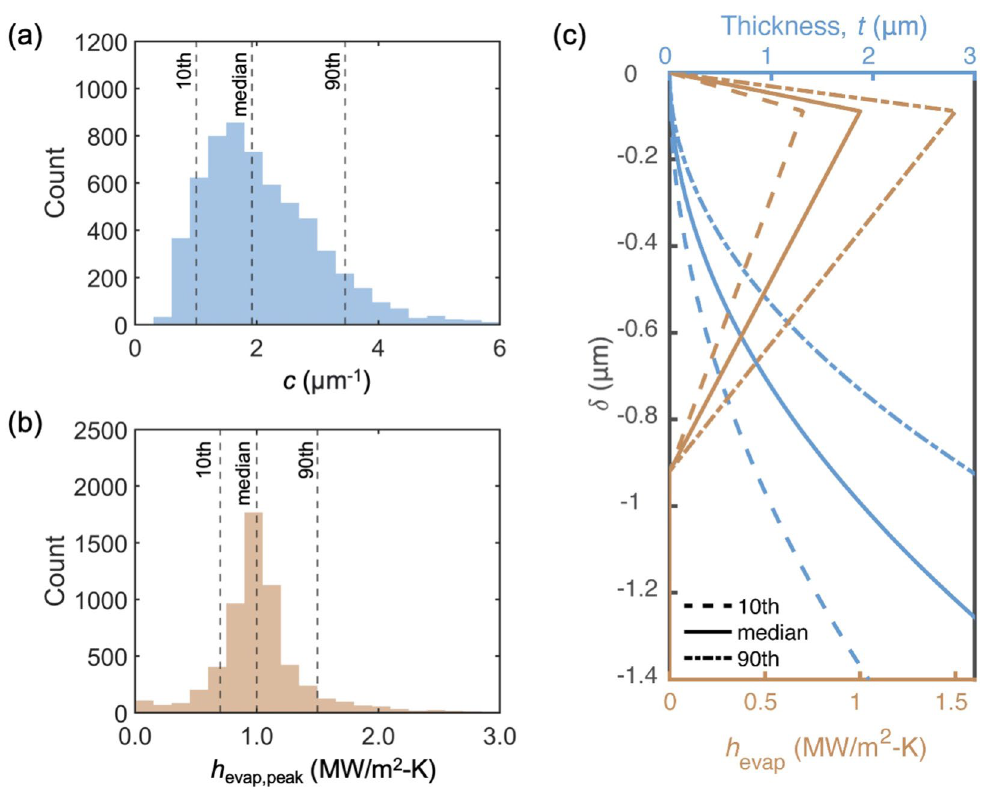
Figure 3. Distributions of ( a ) interface shape coefficient c and ( b ) h evap,peak from the neural network run with randomized seeds. The dashed vertical lines show the 10th percentile, median value, and 90th percentile. ( c ) h evap and meniscus shape profiles. The solid lines indicates the profiles using the median values. The dashed lines and dashed dotted lines indicate the profiles using the 10th and 90th percentile